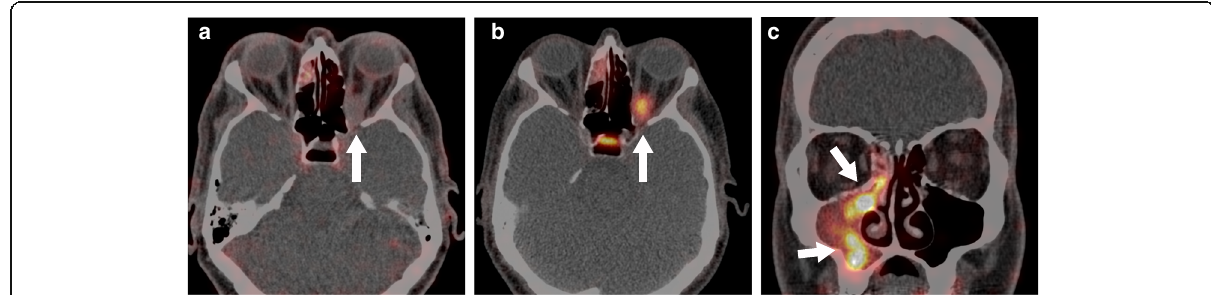
Fig. 2 Patient with a meningioma in the left orbital apex and sinusitis of the right maxillary sinus (case 8). a Negative 89 Zr-rituximab PET/CT (white arrow, SUVmax < 1.0). b Positive 68Ga DOTA-TATE PET/CT, white arrow. c 89 Zr-rituximab uptake in a co-existing sinusitis at the contralateral side, white